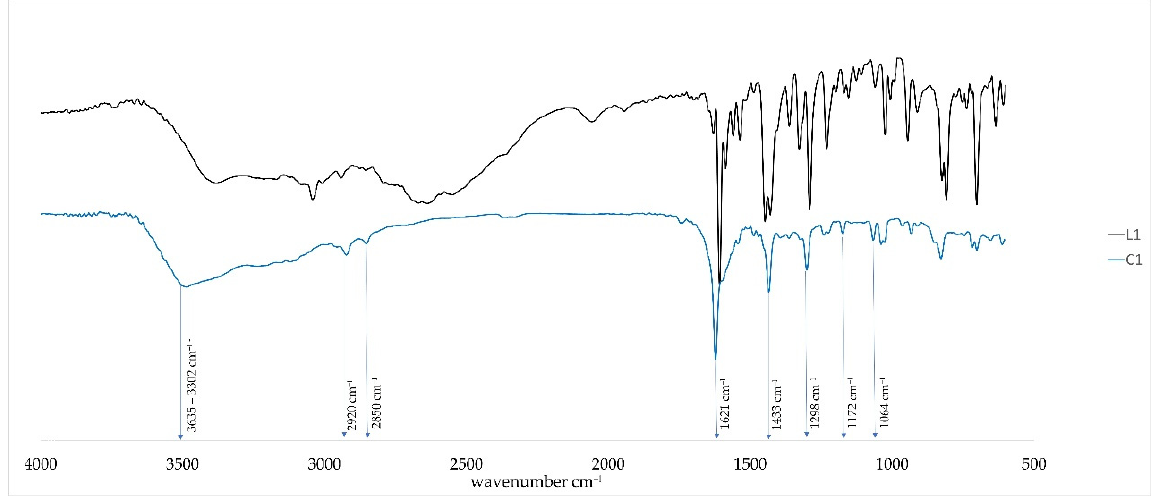
Figure 1. FTIR spectrum of free organic ligands L1 and complex C1.